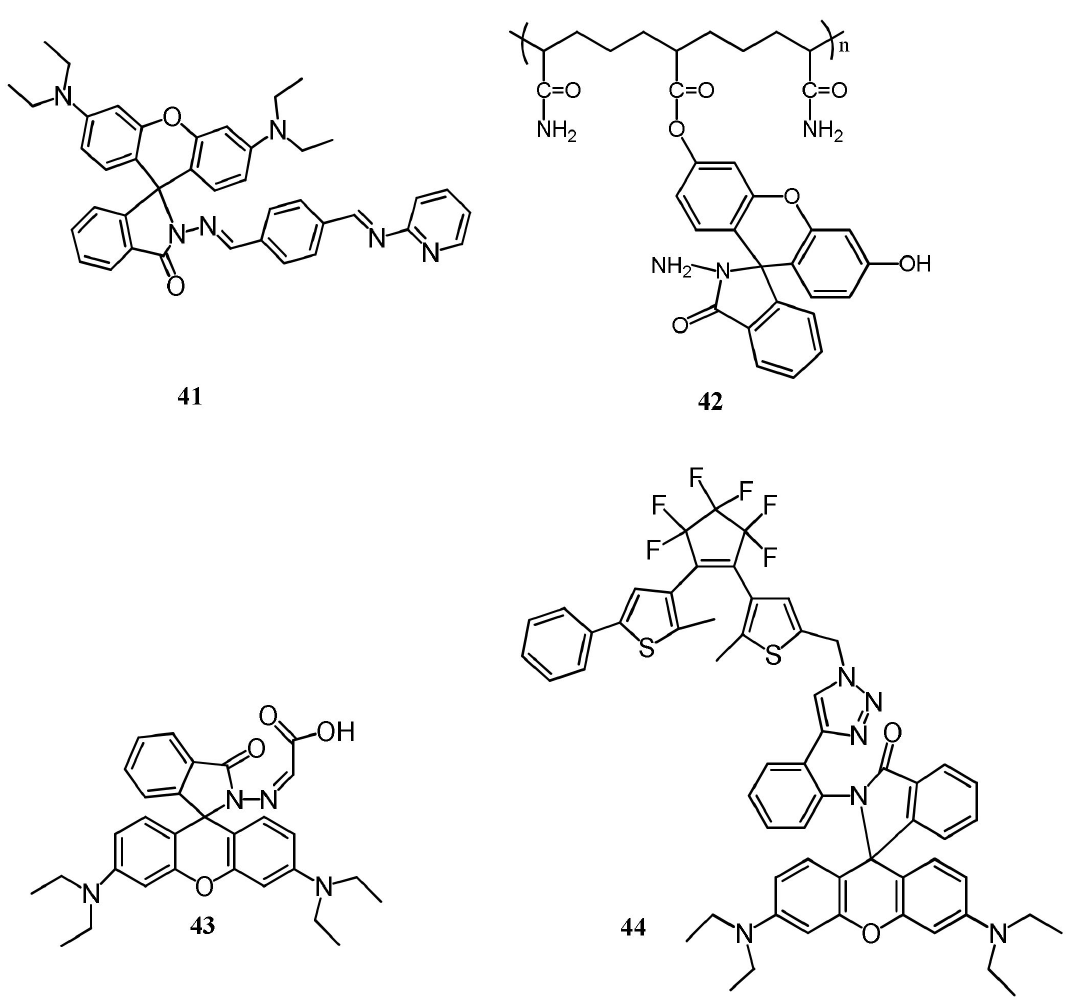
Figure 14. Molecular structures of the sensors 41 to 44